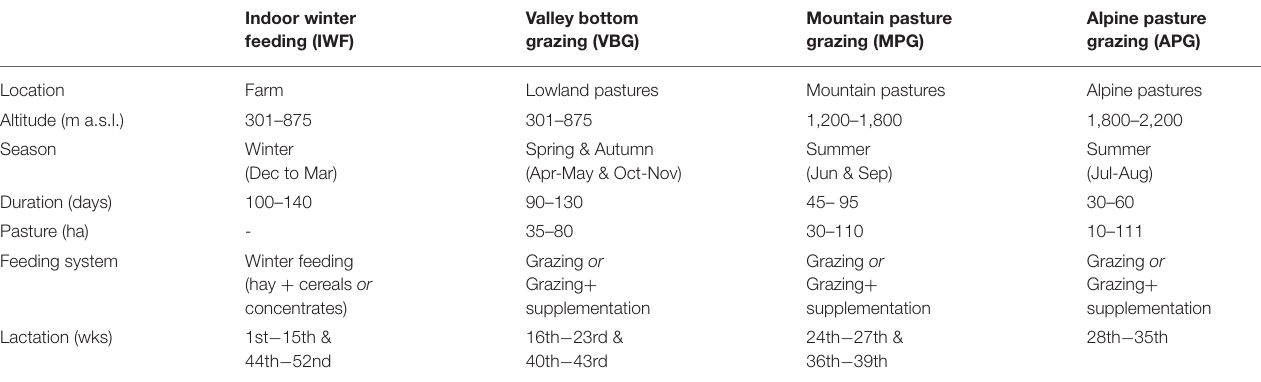
TABLE 1 | Characteristics of the four